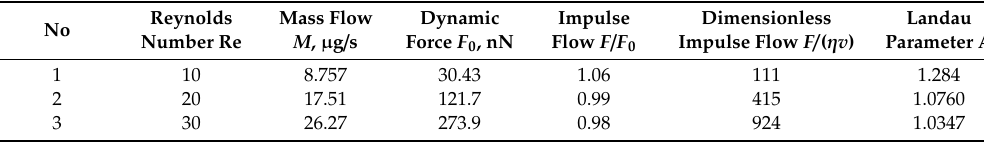
Table A2. Jet parameters at evaporation spot of D = 50 µ